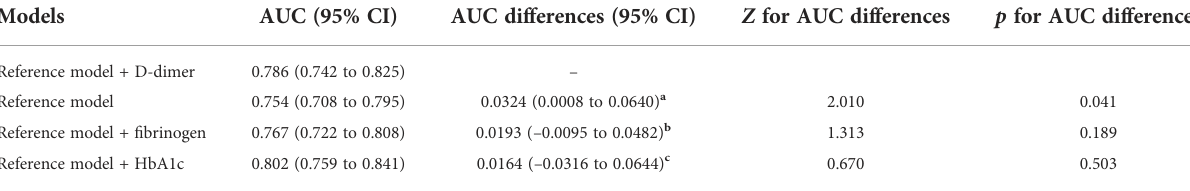
TABLE 4 Performance of plasma D-dimer to discriminate DPN after adjustment for traditional risk factors.